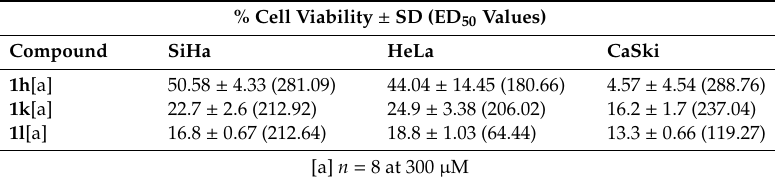
Table 1. E ff ect of the studied compounds 1h , 1k , and 1l on viability of cervical cancer cell lines SiHa, HeLa, and CaSki.